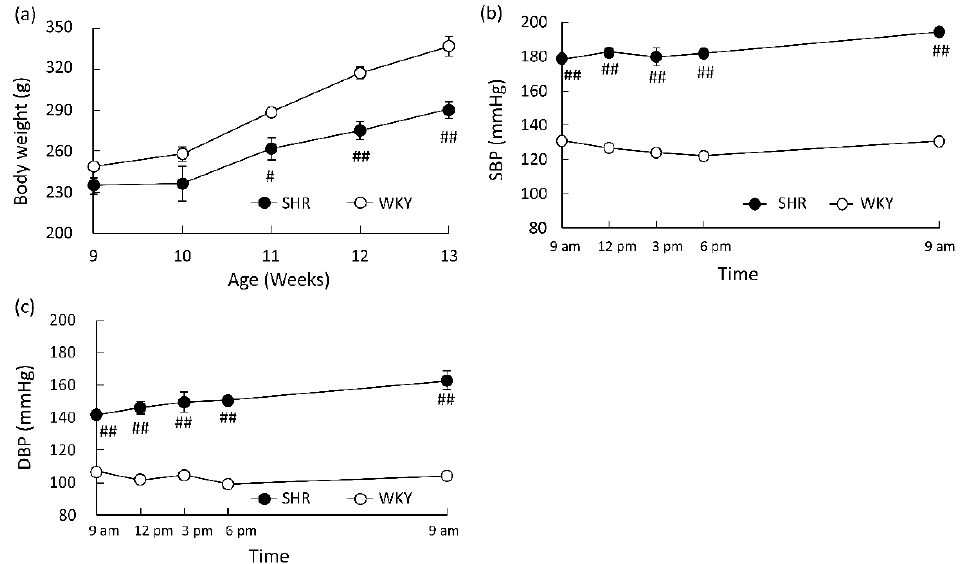
Figure 1. General conditions of SHRs and WKY rats. SBP ( a ) and DBP ( b ) at 9 weeks of age. Body weight at 9–13 weeks of age ( c ). ○ : WKY rats (n = 4), ● : SHRs (n = 4). Each data point and error bar represent the mean ± S.E. # p < 0.05, ## p < 0.01, versus WKY/Izm, as evaluated by a Student’s t -test. SBP, systolic blood pressure; DBP, diastolic blood pressure; SHR, spontaneously hypertensive rat; WKY, Wistar–Kyoto.